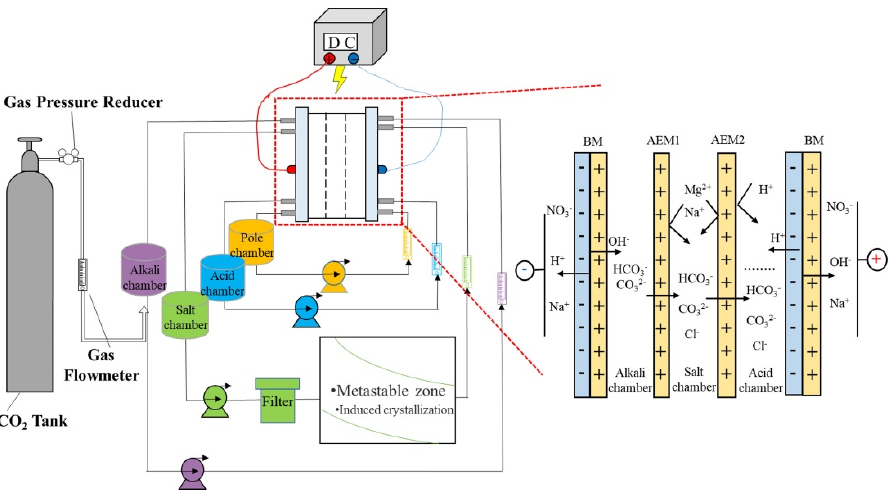
Figure 15. Experimental schematic diagram for magnesium extraction and CO 2 mineralization [91].